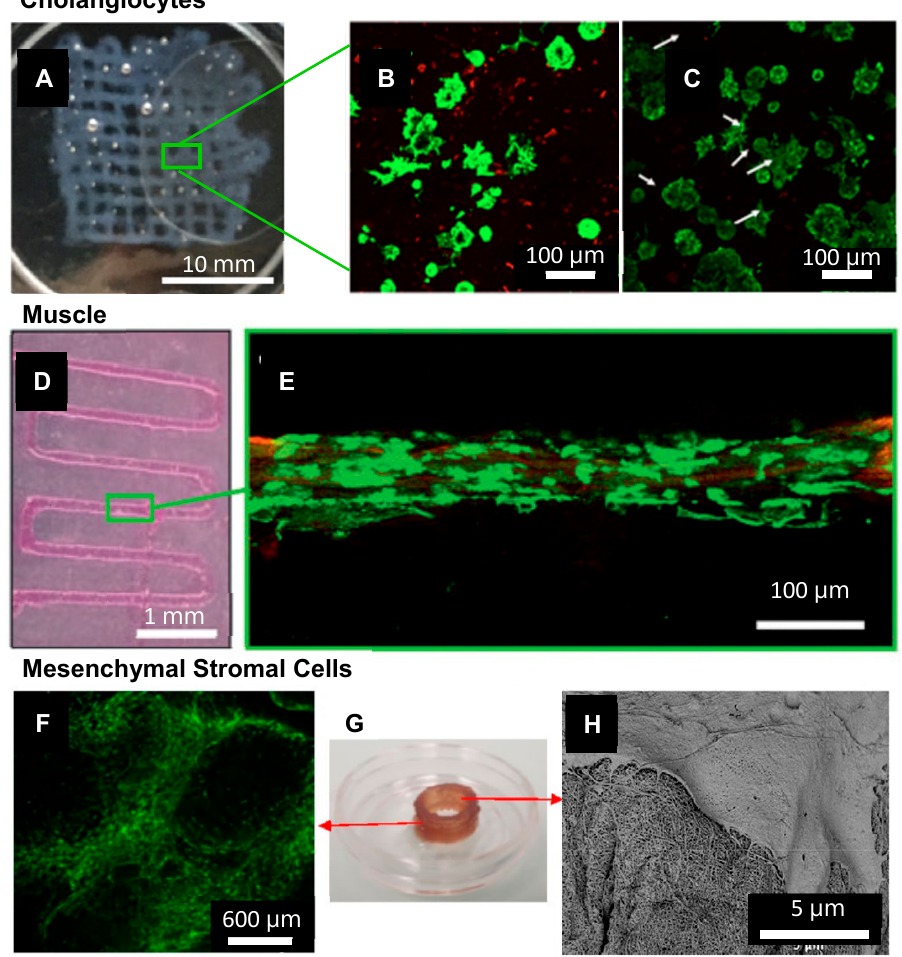
Figure 4. SAP bioinks have been used for the biofabrication of several cell/tissue types including ( A – C ) Cholangiocytes . (A) 3D bioprinting IKVAV-ink via extrusion through a 250 µm tip into a 15 mm × 15 mm grid, treated by secondary crosslinking solution. Scale bar is 10 mm. (B) Live/Dead stain of cholangiocytes in IKVAV-ink for 7, and (C) 14 days. Scale bars are 100 µm. Adapted with permission from Yan et al. 2018 Copyright IOPScience [188] ( D – E ) Muscle . (D) 3D bioprinting of PA-bioink on a CaCl 2 -coated glass coverslip using a 200 µm nozzle. Scale bar is 1 mm. (F) Confocal image of myoblast cells encapsulated in a filament after seven days in culture, stained with Calcein-AM (green) showing live cells aligned along the fibre axis. Scale bar is 100 µm. Adapted with permission from Sather et al. 2021 Copyright Wiley-VCH [82]. ( F – H ) MSCs (F) Long-term (30 days) cell viability of hBM-MSCs post-printing of a 1 cm cylindrical construct using IZZK peptide. Scale bar 600 µm. (G) Printed construct after 30 days (H) SEM of printed hBM-MSCs after ten days of culture showing an interaction between the cell’s filopodia and the matrix. Scale bar 5 µm. Adapted with permission from Susapto et al. 2021 Copyright ACS [81].